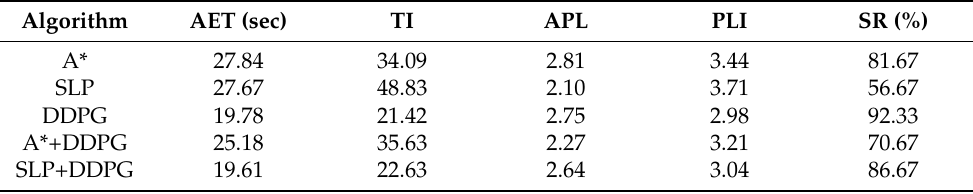
Table 2. Test Case 2 (Dynamic